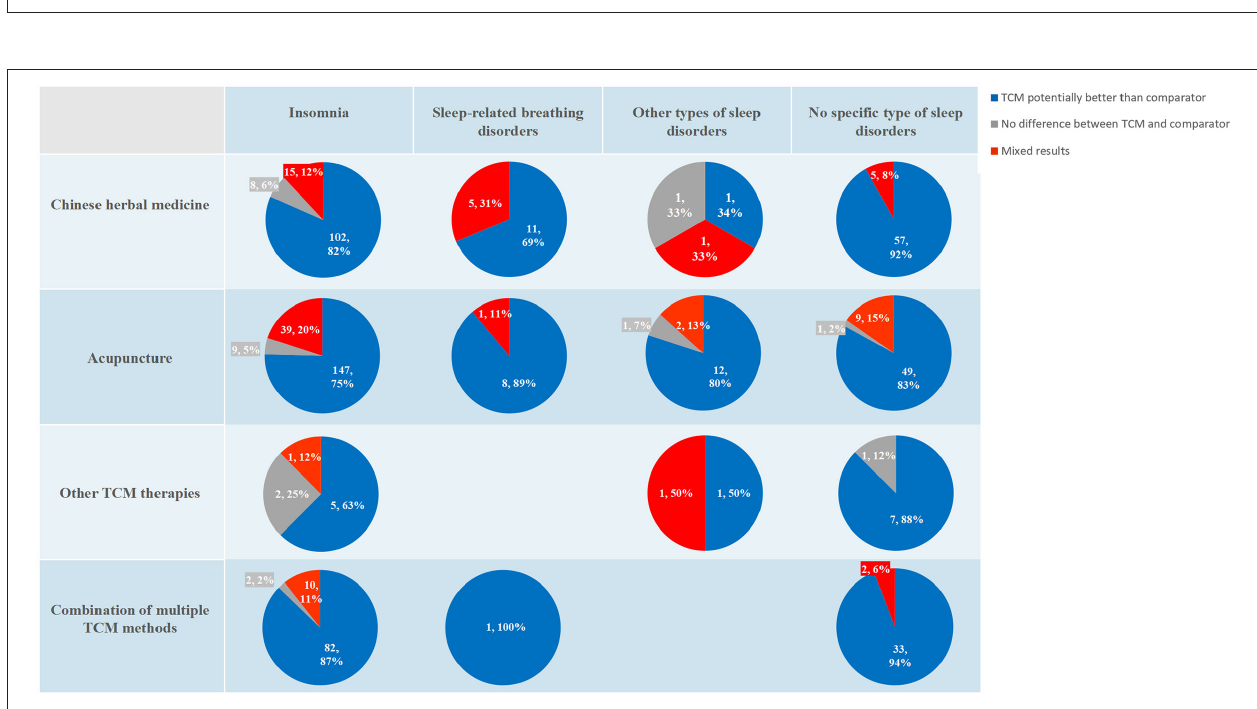
FIGURE 6 | The effectiveness of traditional Chinese medicine on post-stroke sleep disorders: evidence synthesis of randomized controlled trials. The results are presented with the number of studies (%). TCM, traditional Chinese medicine.